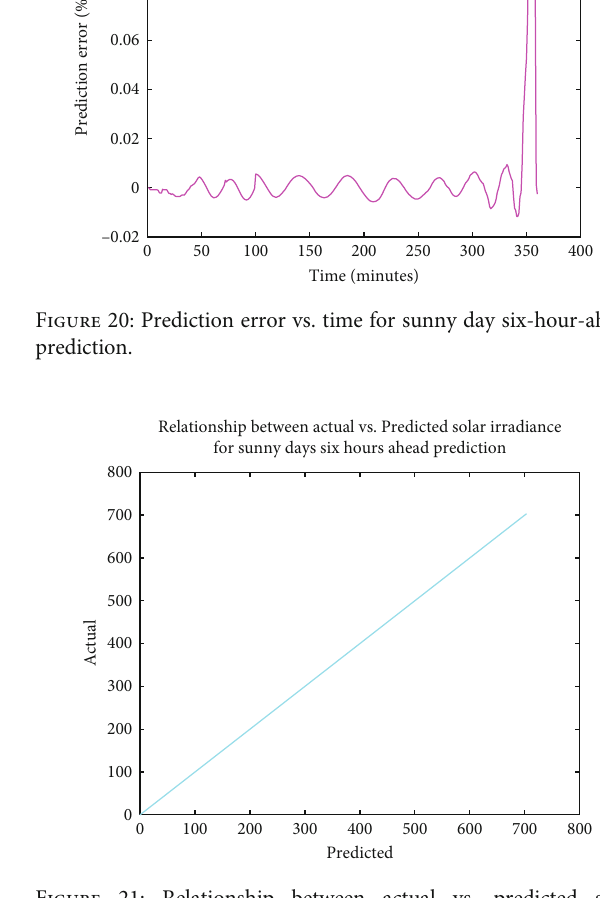
Figure 21: Relationship between actual vs. predicted solar irradiance for sunny day six-hour-ahead The proposed CLSTMN mathematical model is as fol- lows: